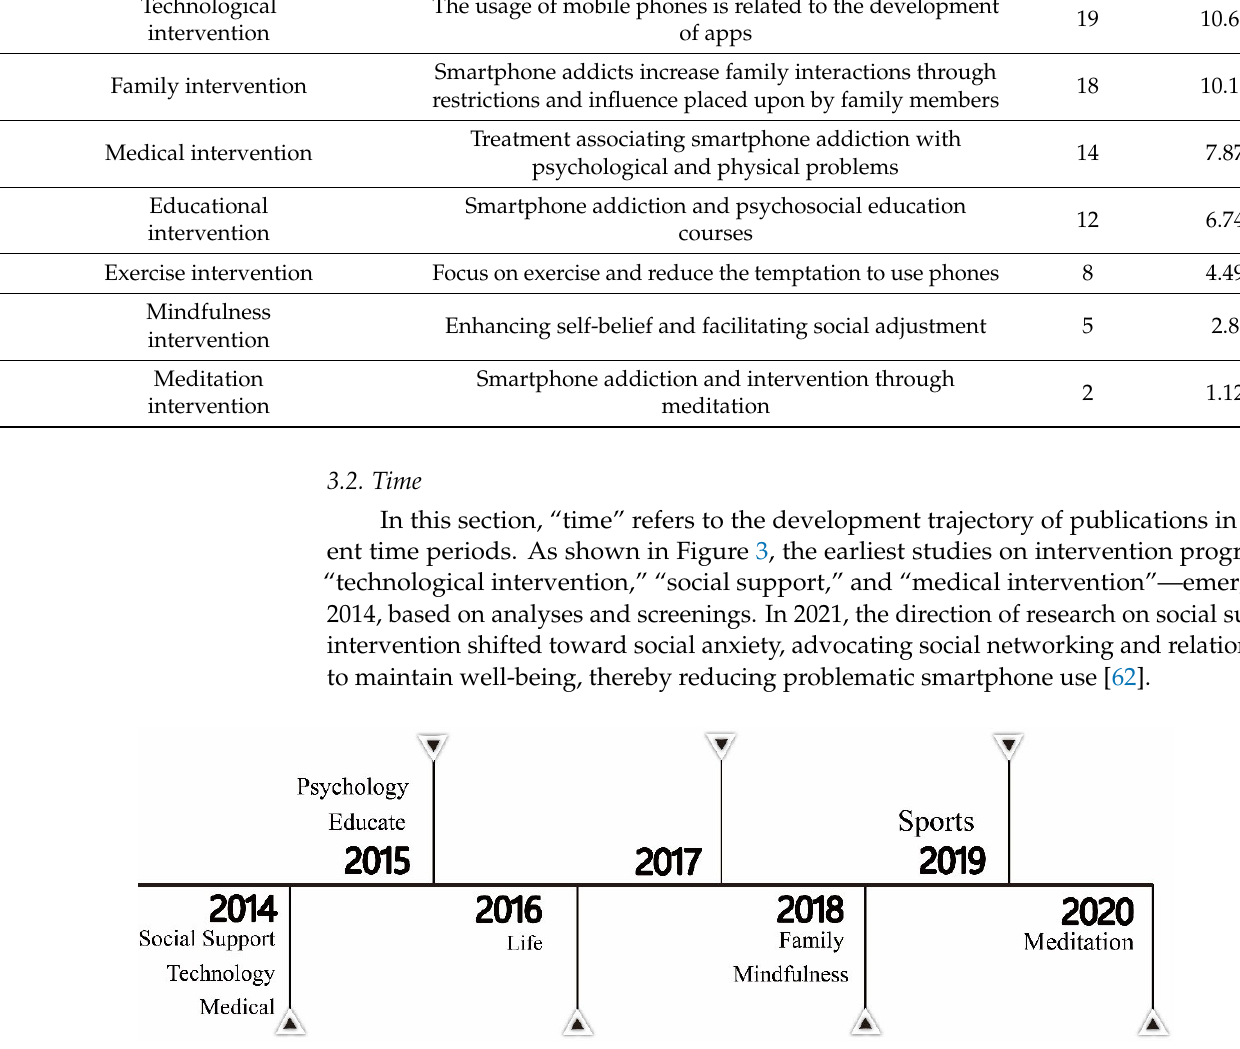
Figure 3. Emergence of each type of intervention program.